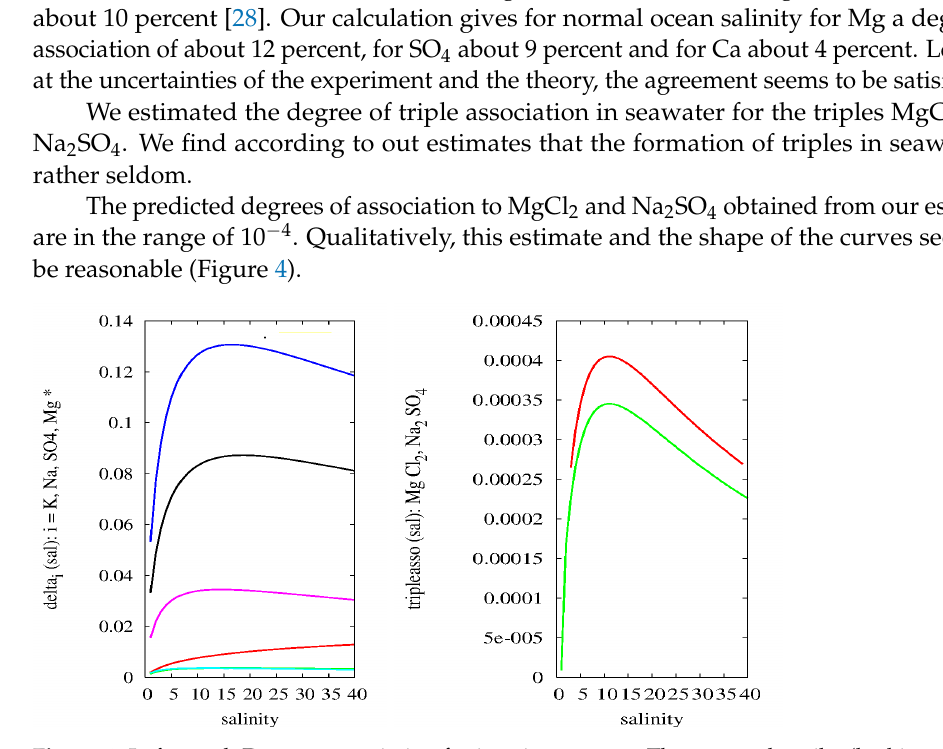
Figure 4. Left panel: Degrees association for ions in seawater. The curves describe (looking at mean salinities from above): Mg 2 + , SO 2 − , Ca 2 + , Na + , K + , Cl − , as a function of salinity. Right panel: 4 Degree of triple association in seawater for the triples MgCl 2 (red) and Na 2 SO 4 (green) which is according to our estimates rather low. Typical is the maximum at finite